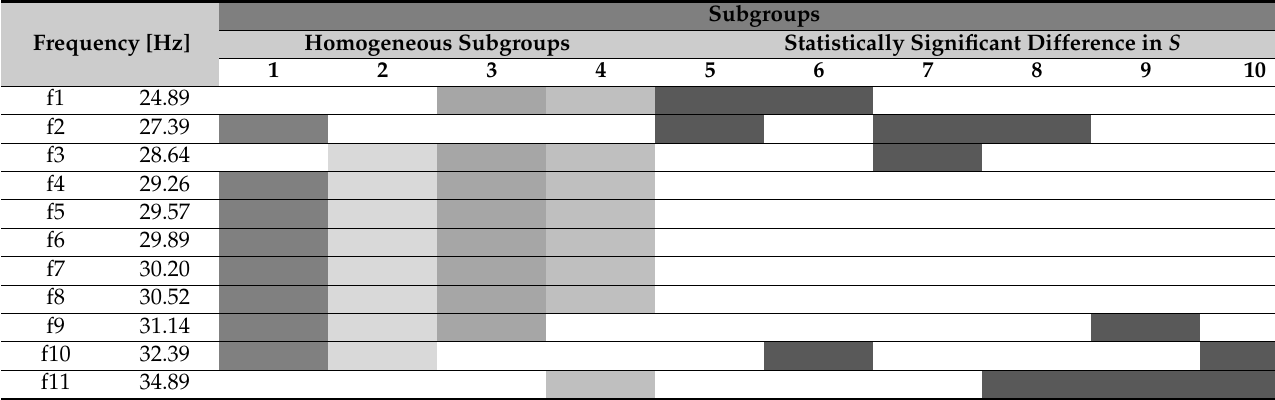
Figure 7. Means and 95% Bonferroni intervals of 1 series of experiments.